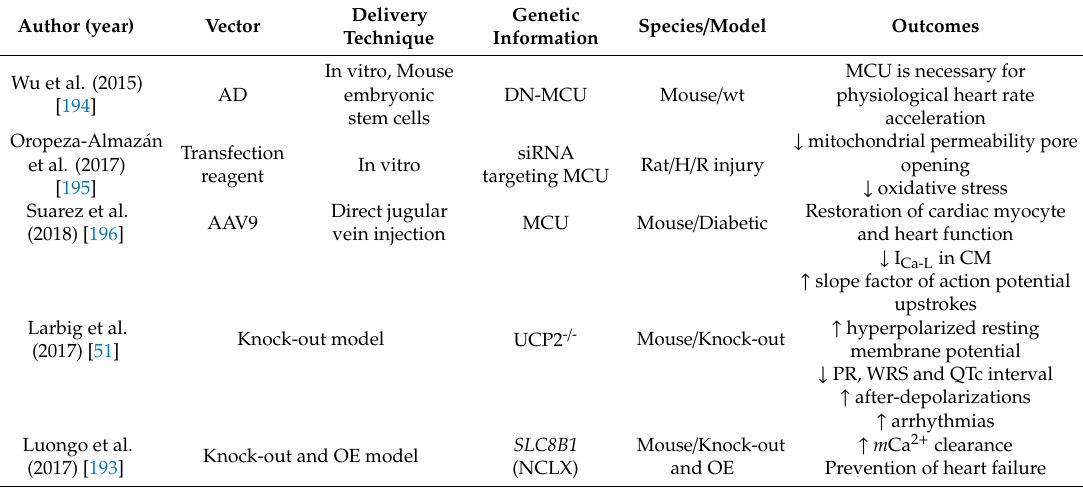
Table 6. Gene therapies for HF and inherited cardiac diseases targeting mitochondrial proteins, such as N + / Ca 2 + exchanger